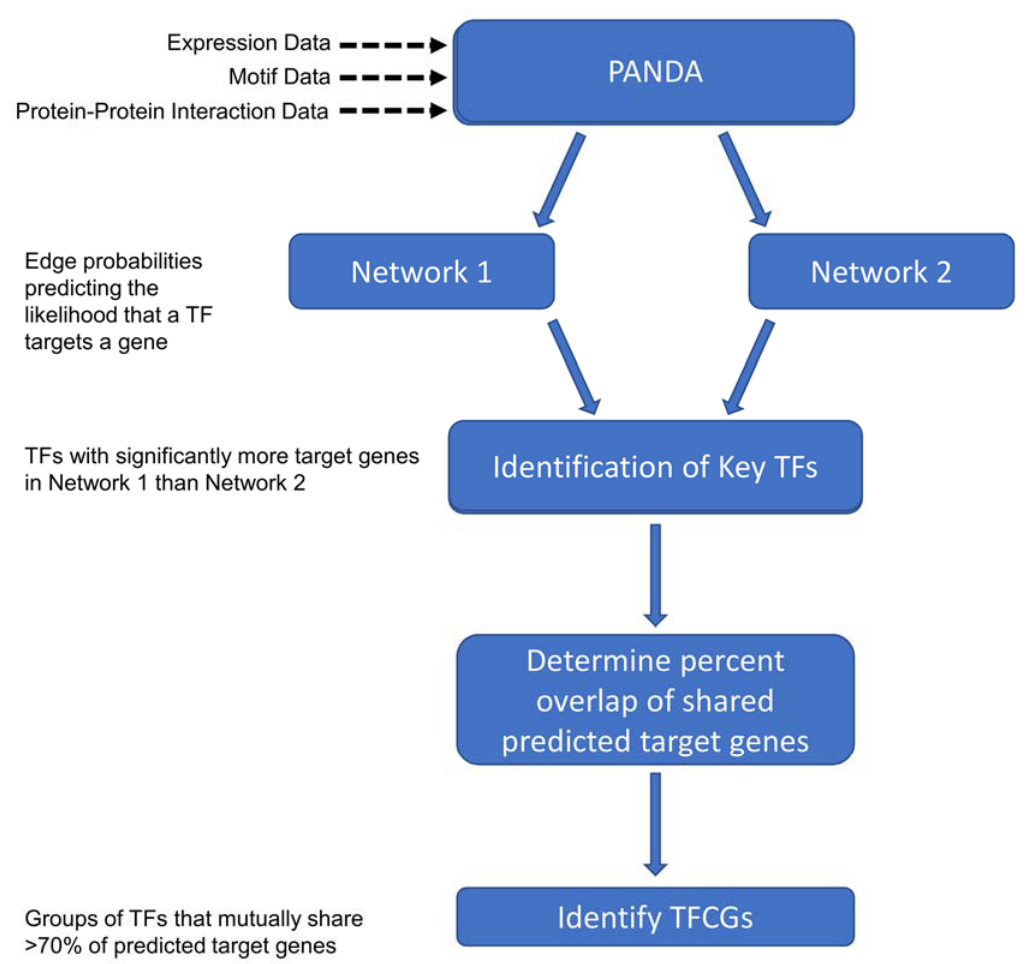
Figure 3. A flowchart depicting the how transcription factor coordinated groups (TFCGs) were identified. Expression-, motif-, and protein interaction data were used as inputs to PANDA. This was run twice using two independent expression datasets (e.g., high- and low impact expression data) to generate networks. Post-processing of the PANDA output (refer to methods) yielded edge probabilities representing the likelihood that a transcription factor targets a given gene. Next, Key TFs were found based on the criteria that a TF gains a significant number of predicted target genes in one network versus another. After determining the percentage overlap of shared predicted target genes (refer to methods), TFCGs were ascertained as groups of Key TFs that share >70% of the predicted target genes.